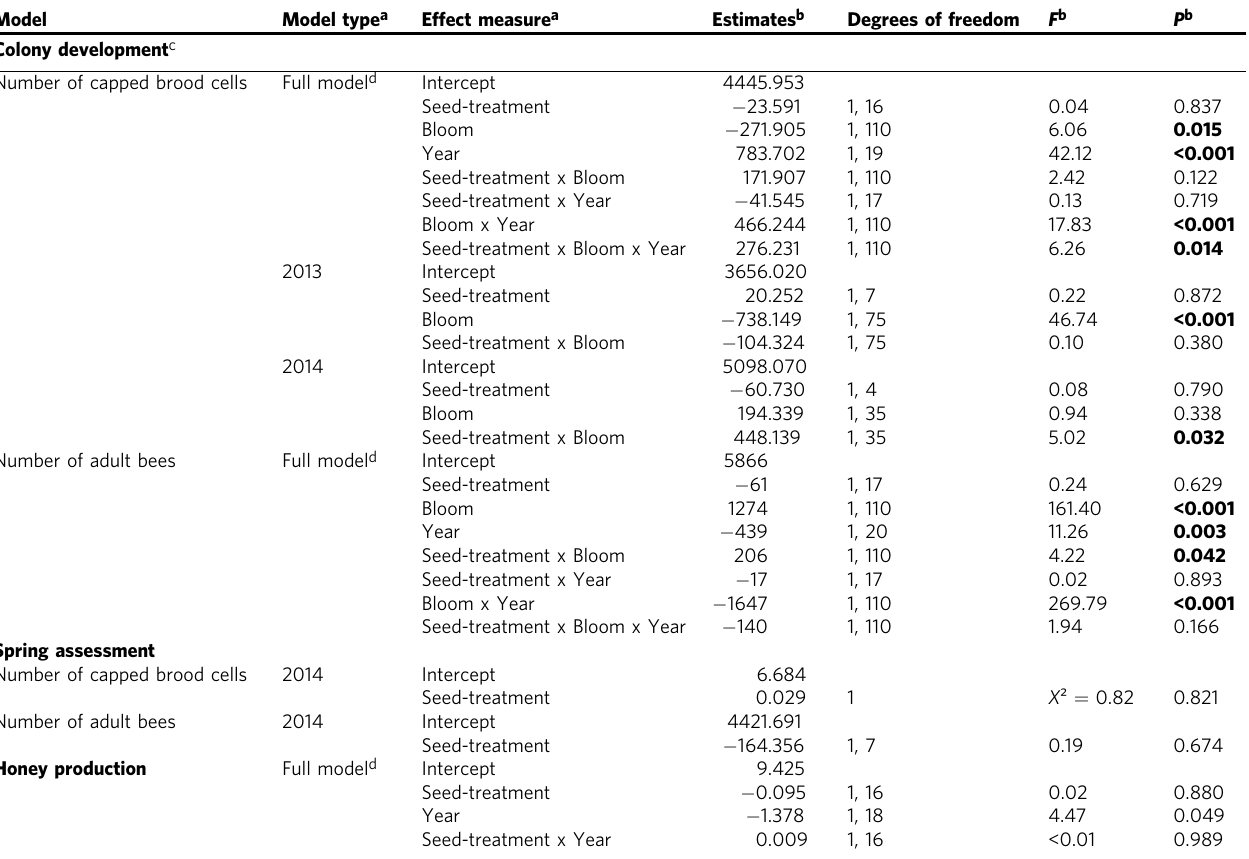
Table 2 Colony development and honey production in relation to fi xed effects